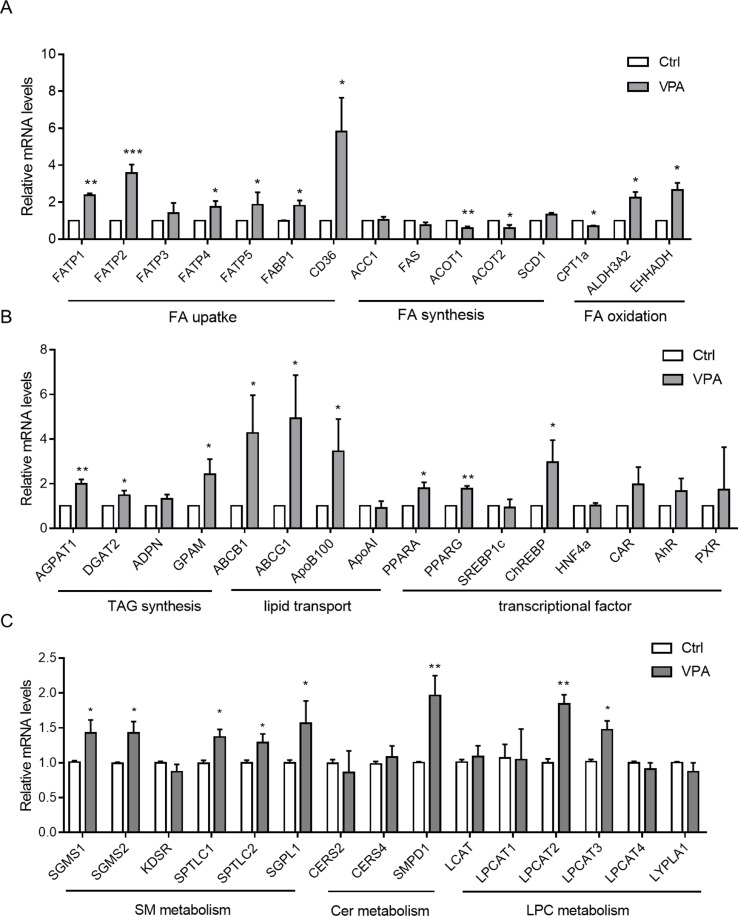
Hepatic mRNA levels of genes associated with metabolism of FA (A); TAG, transporters, and transcriptional factors (B); and SM, Cer, and LPC (C) in L02 cells treated with VPA. Target gene mRNA levels are normalized to those of GAPDH and subsequently normalized to those of control groups. Values are presented as mean ± SD (n = 3); *P < 0.05, **P < 0.01, ***P < 0.001 compared with the control group.